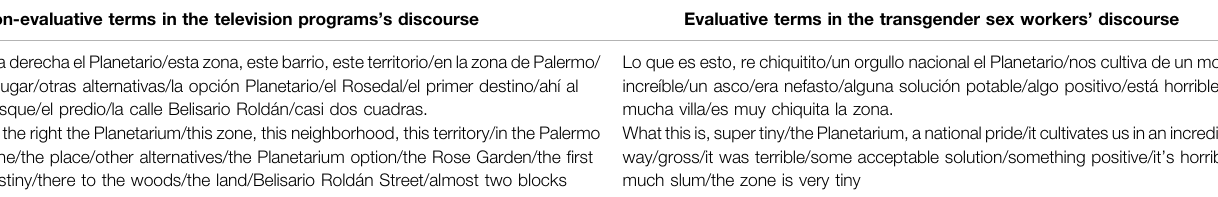
TABLE 5 | The semantic construction of the Space category in the discourse of the television program and the transgender sex workers. Non-evaluative terms in the television programs ’ s